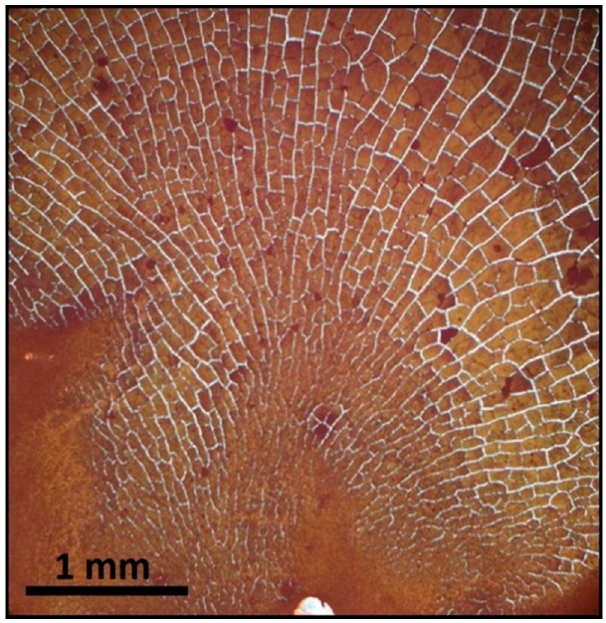
Figure 9. Formation of orthogonal blocks by 536 nm diameter MSNs arrays under a perpendicular to the substrate applied field B = 0.06 T.